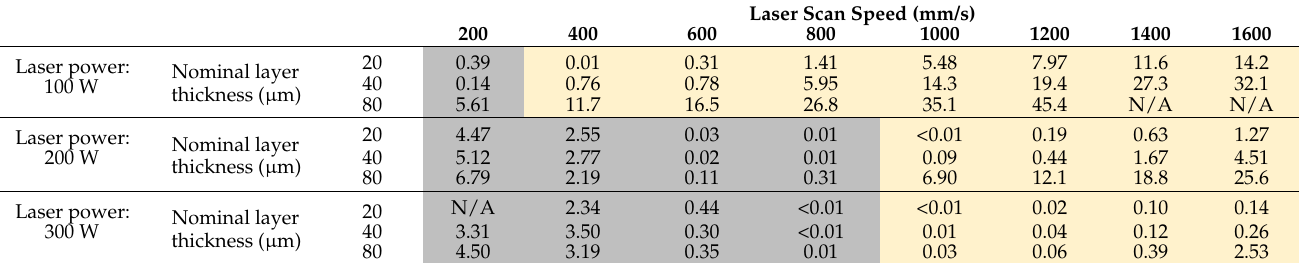
Table 1. Volume fraction of flaws (%) across the process parameter space. Laser power, scan speed and layer thickness are varied systematically. Cells in gray correspond to process conditions in the keyhole regime; cells in yellow correspond to the conduction regime. “N/A” indicates manufacturing could not be completed due to extreme processing conditions.